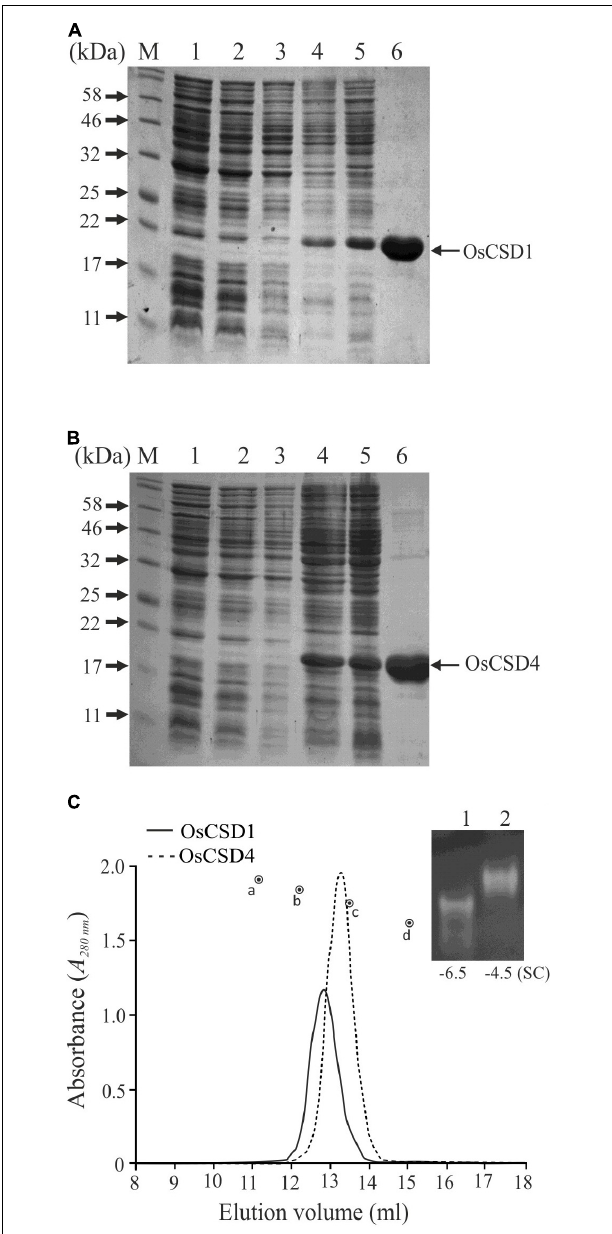
FIGURE 4 | Overexpression and purification of recombinant rice cytosolic OsCSDs. (A) OsCSD1: lane 1, pET28a(+) uninduced; lane 2, pET28a(+) induced; lane 3, pET28(+)-OsCSD1 uninduced; lane 4, pET(+)-OsCSD1 induced; lane 5, pET(+)-OsCSD1-induced supernatant fraction; lane 6, Ni-NTA affinity-purified OsCSD1; lane M, Protein molecular weight standard. (B) OsCSD4: lane 1, pET28a(+) uninduced; lane 2, pET28a(+) induced; lane 3, pET28(+)-OsCSD4 uninduced; lane 4, pET(+)-OsCSD4 induced; lane 5, pET(+)-OsCSD4-induced supernatant fraction; lane 6, Ni-NTA column-purified OsCSD4; lane M, Protein molecular weight standard. (C) Gel-filtration chromatography elution profiles of OsCSD1 and OsCSD4. The standard protein markers used were (a) bovine serum albumin (66.5 kDa), (b) chicken egg albumin (45 kDa), (c) carbonic anhydrase (29 kDa), and (d) cytochrome C (12.4 kDa). The gel photograph shows relative mobility and SOD activities of native OsCSD1 (1) and OsCSD4 (2) in a non-denaturing polyacrylamide gel. “SC” indicates net surface charge on the